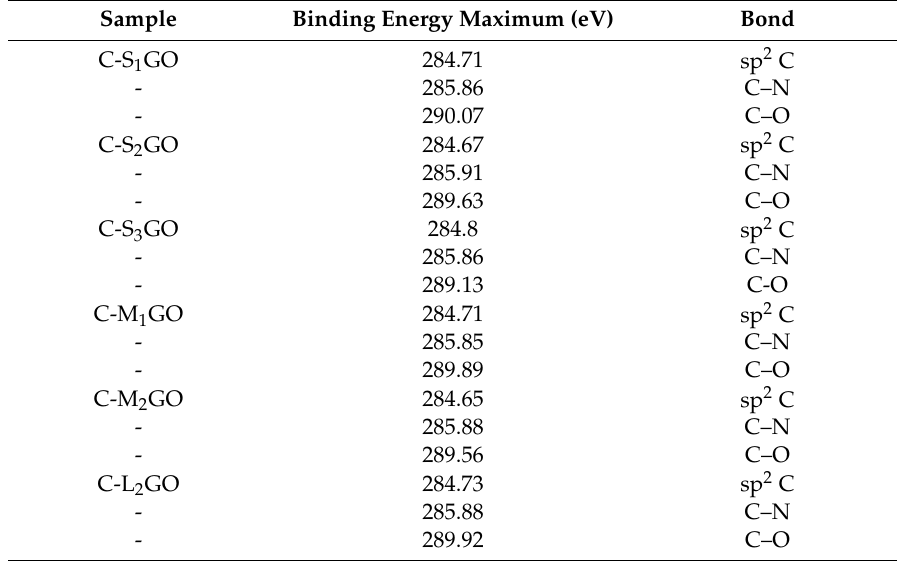
Table 7. Values of binding energies and corresponding carbon bonds in the cross-linked graphene oxide powder obtained by the deconvolution of the C 1s